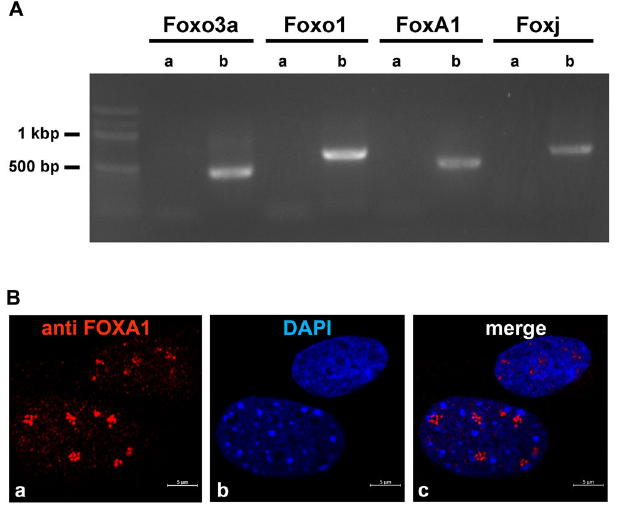
Figure 5. Expression of Fox TFs in NIH3T3 cells. ( A ) Amplification of Fox transcripts by first ( a ) and secondary/nested RT-PCR ( b ). Whereas in the first RT-PCR reaction no amplification products could be identified, the nested PCR performed on the first RT-PCR products as templates revealed products of the expected length of 449 bp ( Foxo3a ), 631 bp ( Foxo1 ), 525 bp ( Foxa1 ), and 674 bp ( Foxj1 ). Correct amplification products were verified by sequencing. The original gel is presented in Supplementary Figure S3. ( B ) Immunological detection of endogenous FOXA1 in NIH3T3 nuclei ( a , red), nuclear stain with DAPI ( b , blue), and merge image ( c ). Bars are of 5